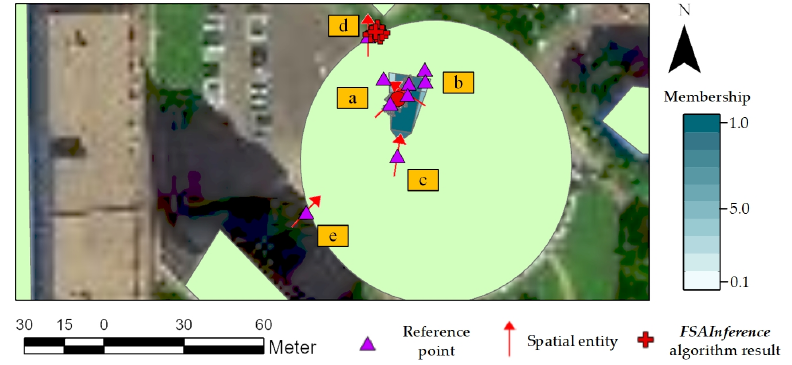
Figure 7. The results of FSREM-OP on description a to e.